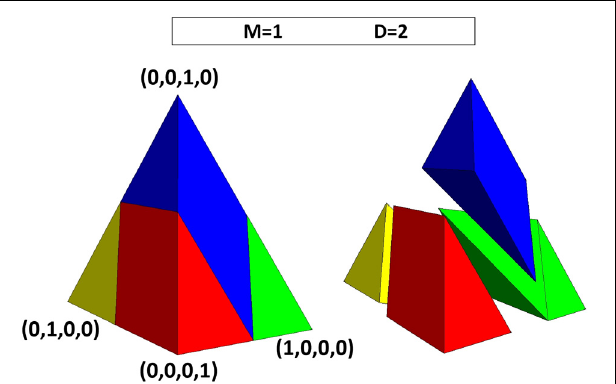
FIGURE 7 | Shape of the basins in the opinion density space (ODS) for M = 1 and D = 2. Left-hand side: three-dimensional view of ODS with the face shown in previous figures turned toward the right. Right-hand side: exploded view of the same ODS, showing the four basins separately. Each basin has the same shape (with five faces: one rhombus, two equilateral triangles, and—facing the interior of the ODS—two isosceles right triangles) and a volume that occupies one quarter of the tetrahedral